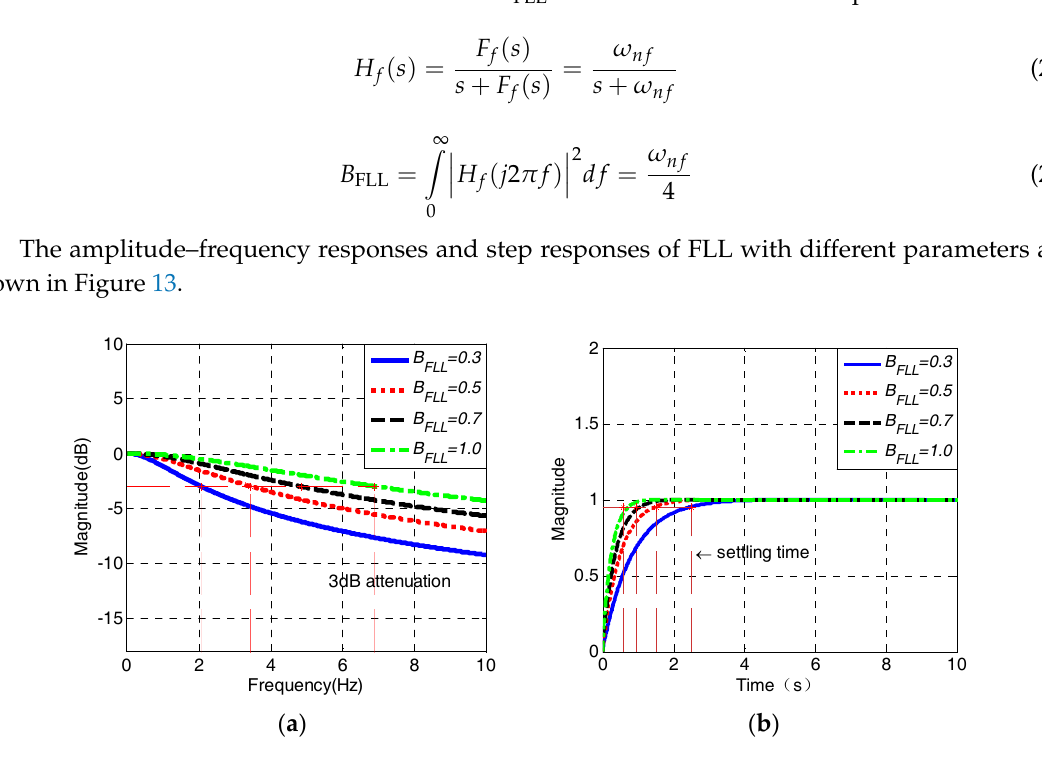
Figure 13. Amplitude–frequency ( a ) and step ( b ) responses of the first-order FLL.